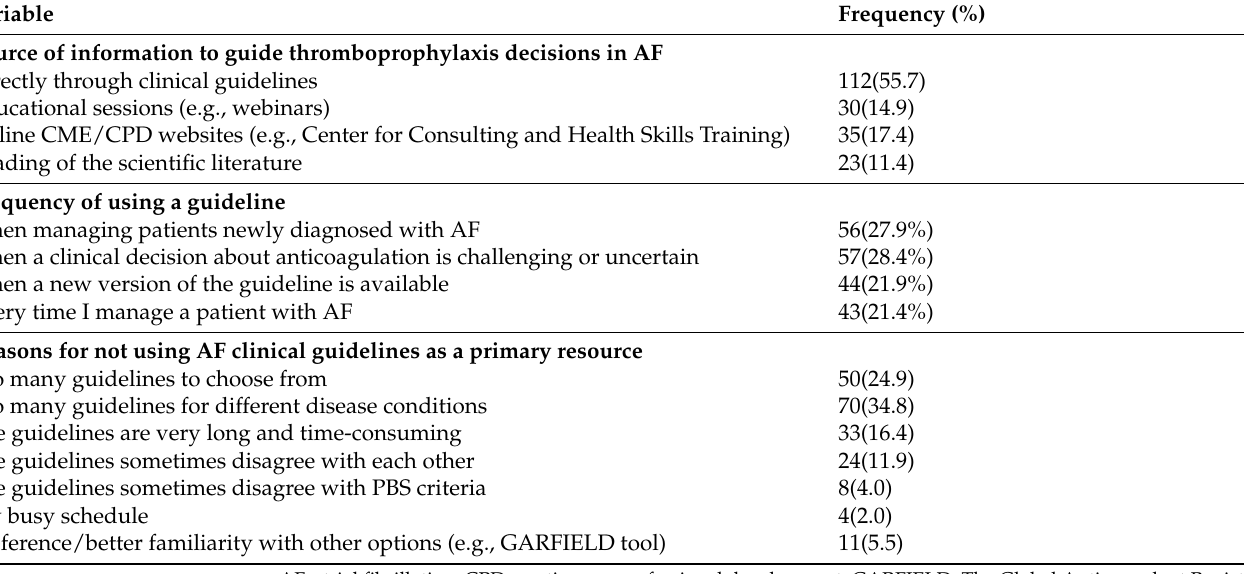
Table 2. Participants’ use of thromboprophylaxis guidelines (n =